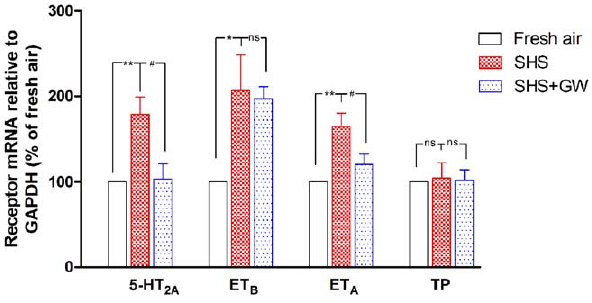
Figure 2. The levels of contractile receptor mRNA expression. The bronchial segments were from rats that were exposed to fresh air, SHS and SHS + GW5074. The receptor (5-HT 2A , ET B , ET A and TP) mRNA level is presented relative to that of the housekeeping gene GAPDH. The values are expressed as the mean 6 SEM (n=5–8). The statistical analysis was performed using one-way ANOVA with Dunnett’s post-test. * P , 0.05, ** P , 0.01 vs. fresh air exposure group; # P , 0.05 vs. SHS exposure group; ns, not